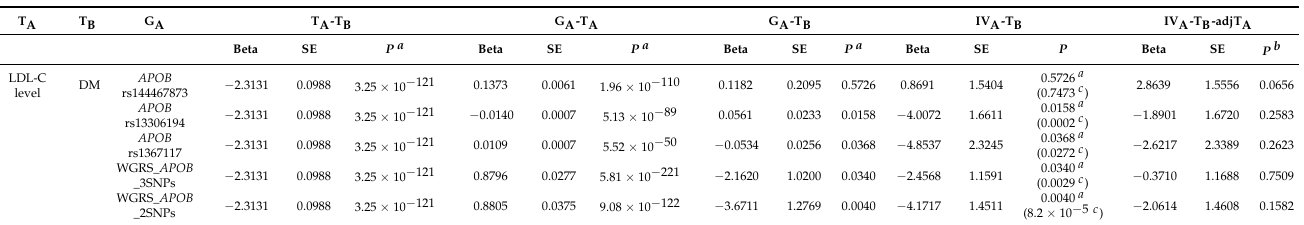
Table 5. Summary of coefficients used for standard Mendelian randomization analysis: low-density lipoprotein cholesterol (LDL-C) levels and diabetes mellitus